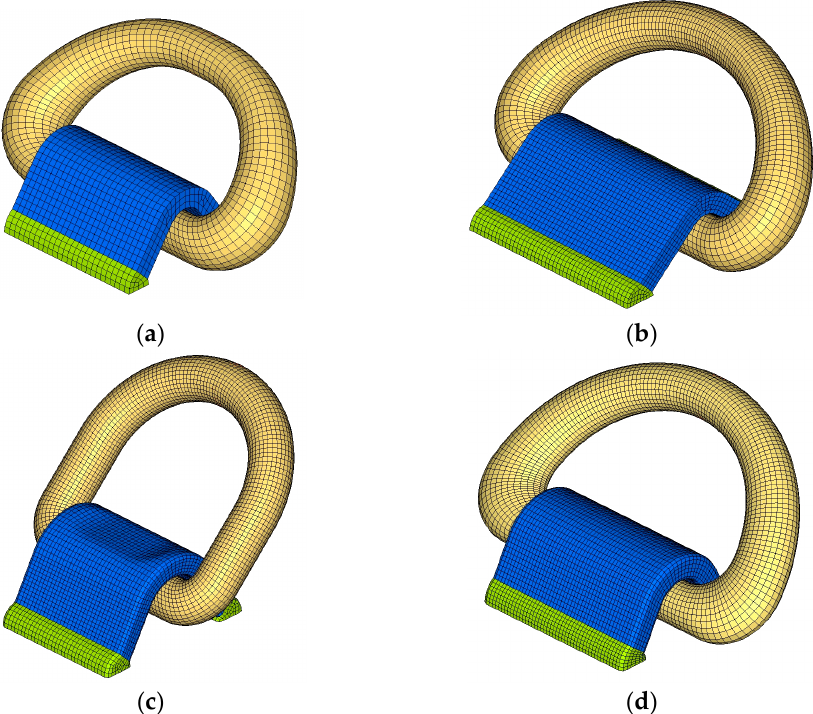
Figure 3. FEM models for the four types of D-Rings. ( a ) Type 1 (3.0 ton f MBL); ( b ) Type 2 (20.0 ton f MBL); ( c ) Type 3 (20.4 ton f MBL); ( d ) Type 4 (25 ton f MBL).